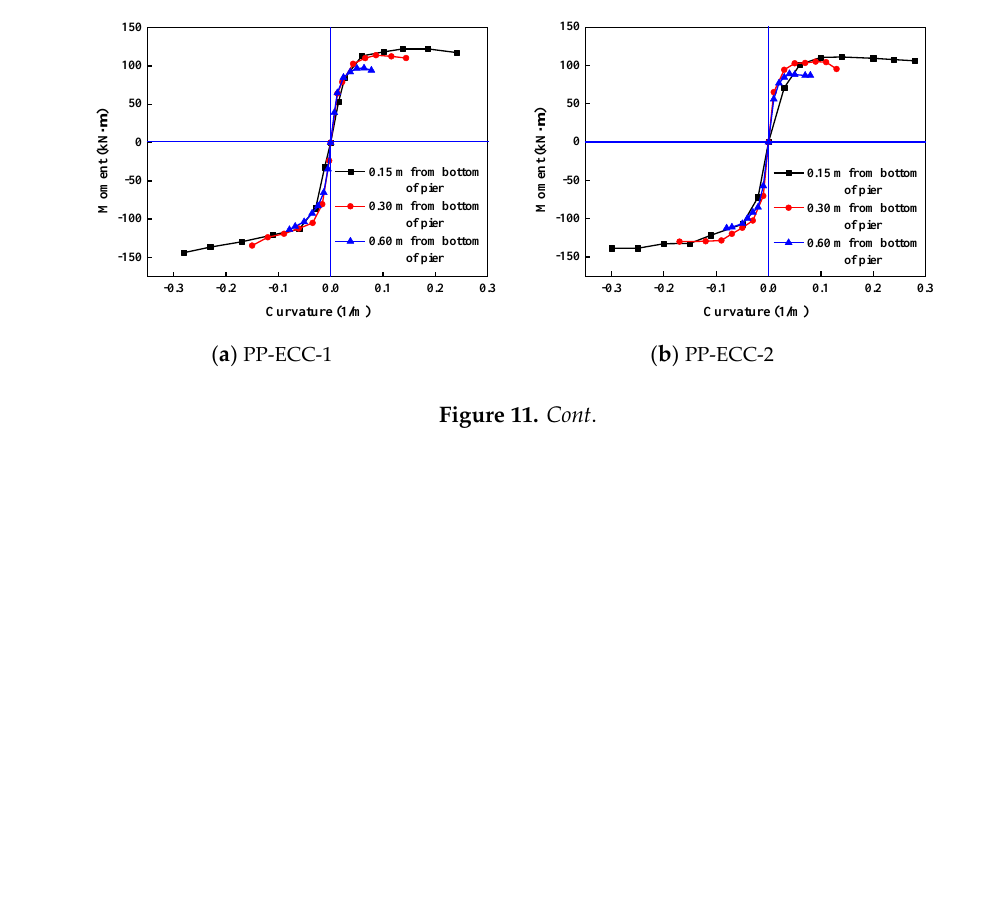
Figure 10. Moment-curvature hysteretic curves of piers at different cross section.